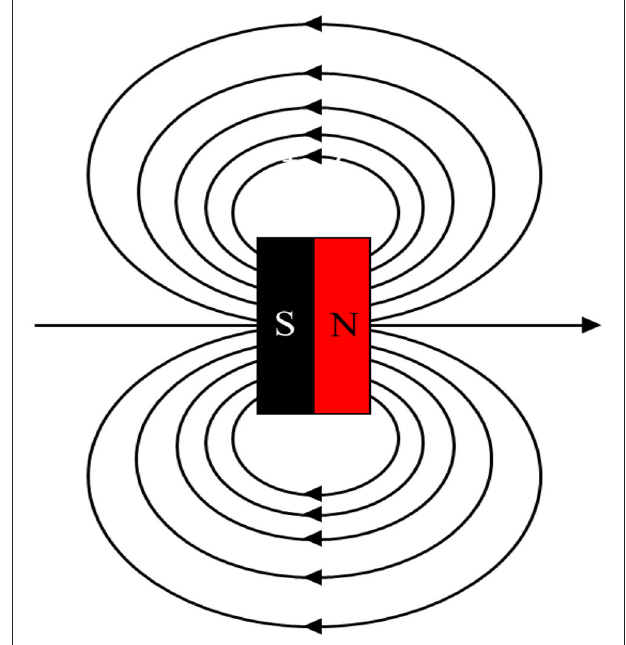
FIGURE 1 | Field lines of diametrically magnetized cylinder, shown with open horizontal field lines.